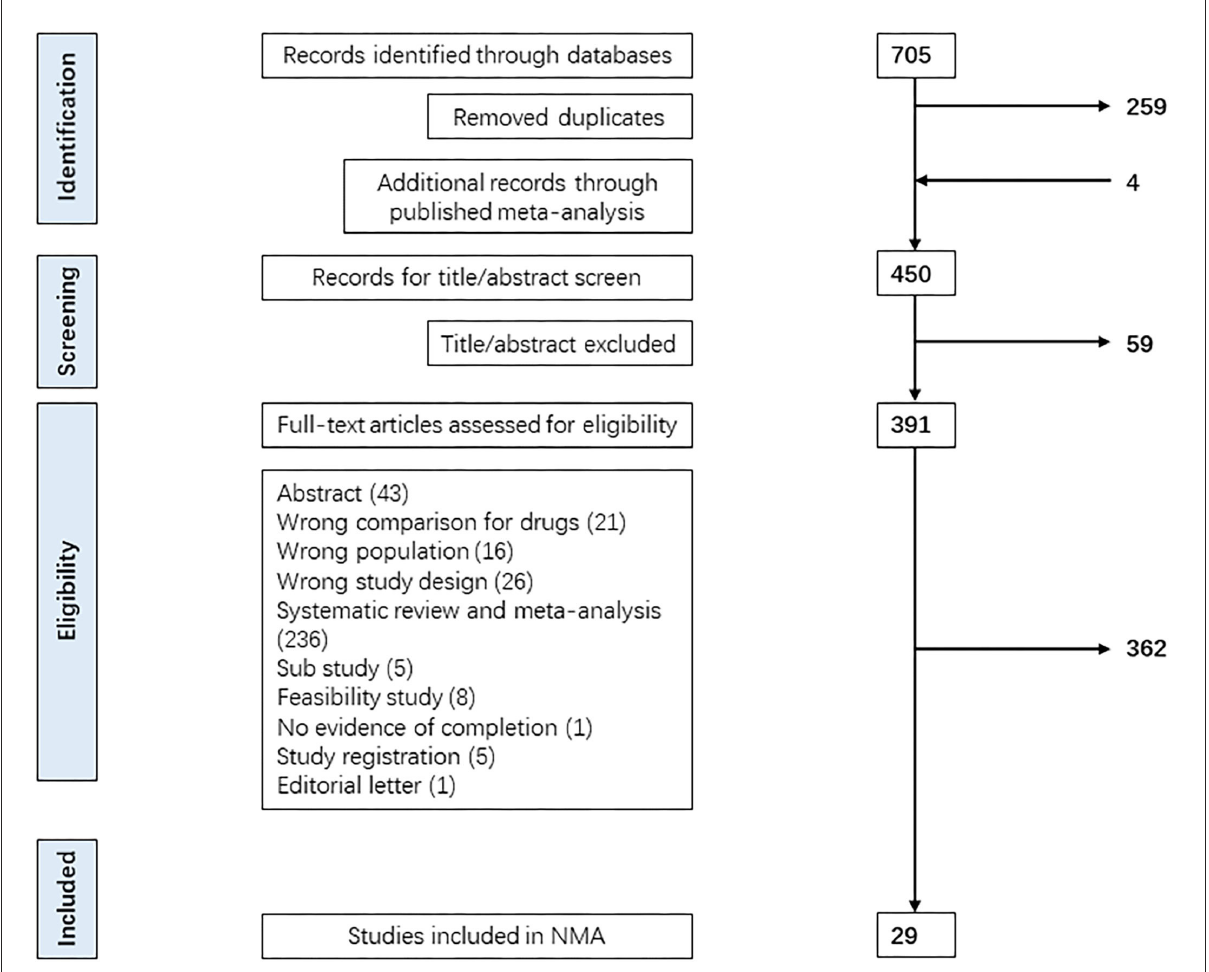
FIGURE1 PRISMA flowchart for the selection of studies. Figure manifested the process of retrieving, evaluating, selecting, or excluding relevant studies from the database. We employed the preferred reporting items for systematic reviews and meta-analyses (PRISMA) diagram for the search.